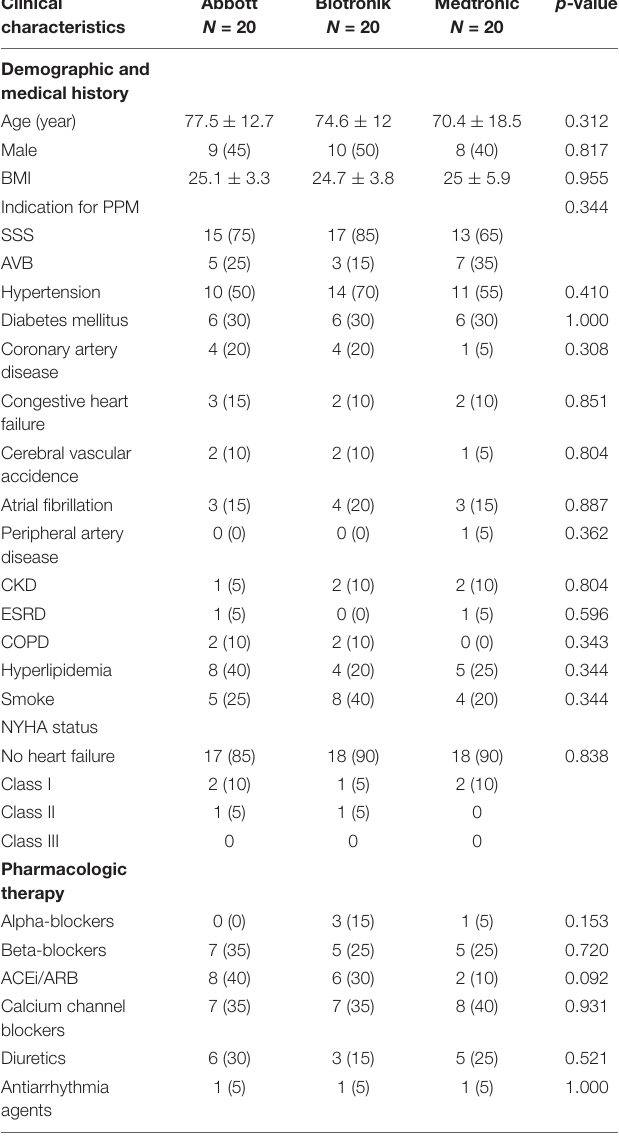
BMI, body mass index; NYHA, New York Heart Association; LVEF, left ventricular ejection fraction; ACEi, angiotensin-converting-enzyme inhibitor; ARB, angiotensin receptor blocker. Continuous values are expressed as mean ± standard deviation (SD) or median (interquartile range); categorical variables are reported as numbers (percentages).